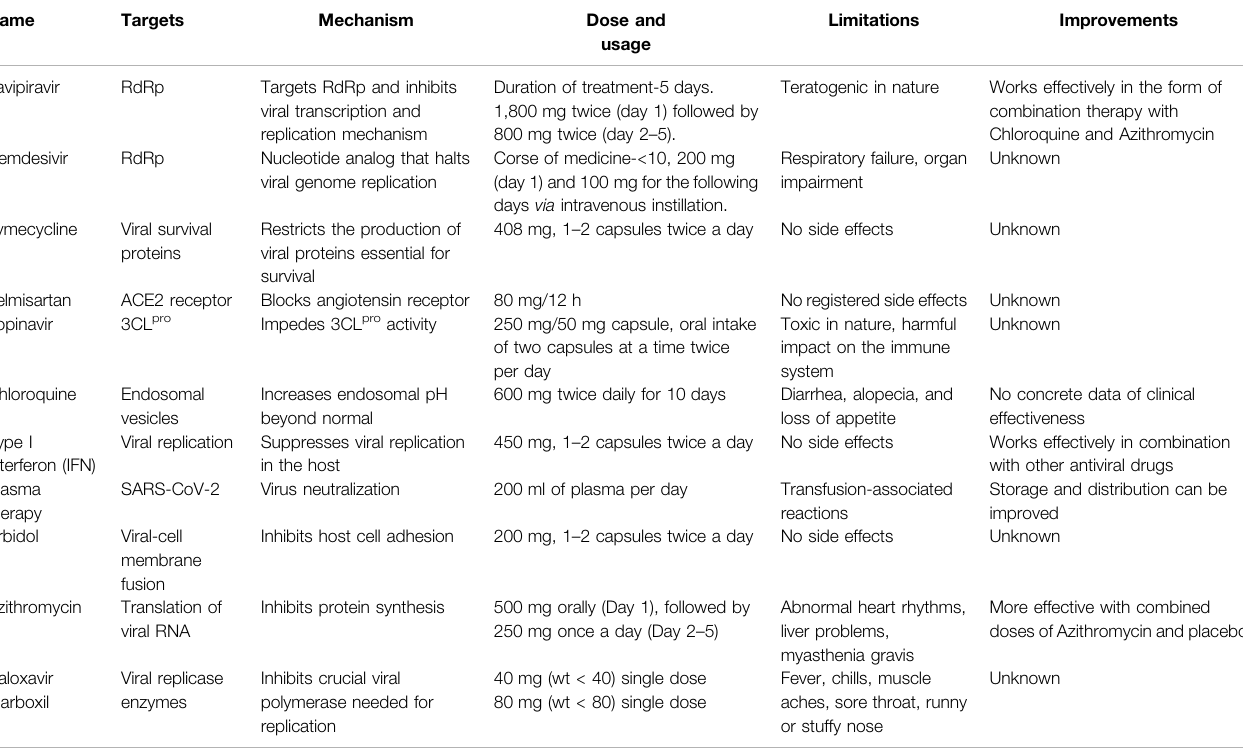
TABLE 1 | Targets, Mechanism of action, required dose, safety pro fi le, and improvements of repurposed anti-SARS-CoV-2